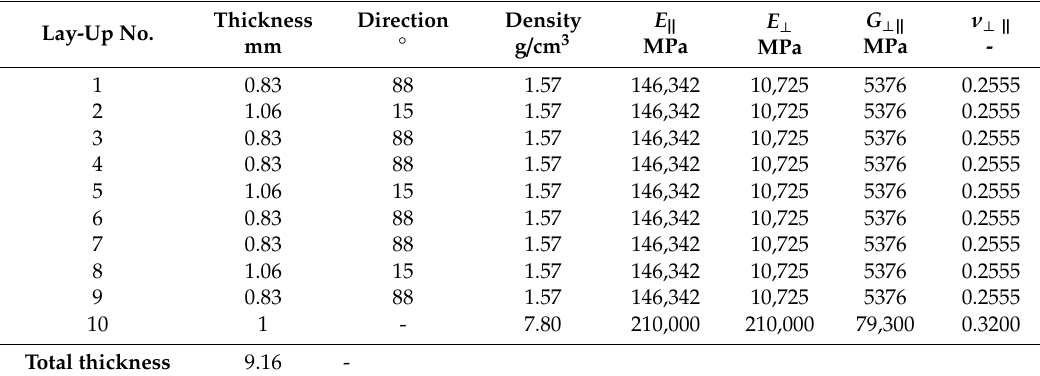
Table 1. Laminate lay-up and the material properties of the CFRP with steel liner prototype. Lay-Up No.